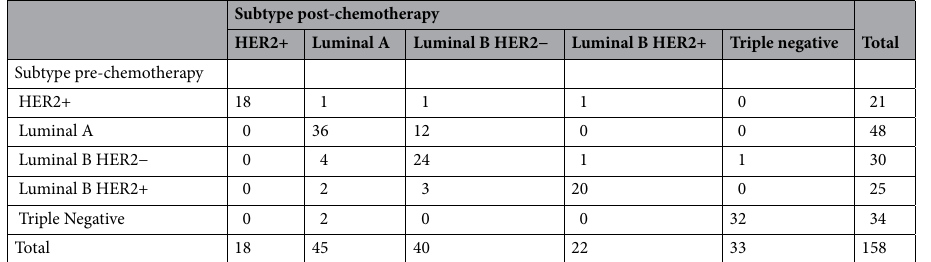
Subtype post-chemotherapy